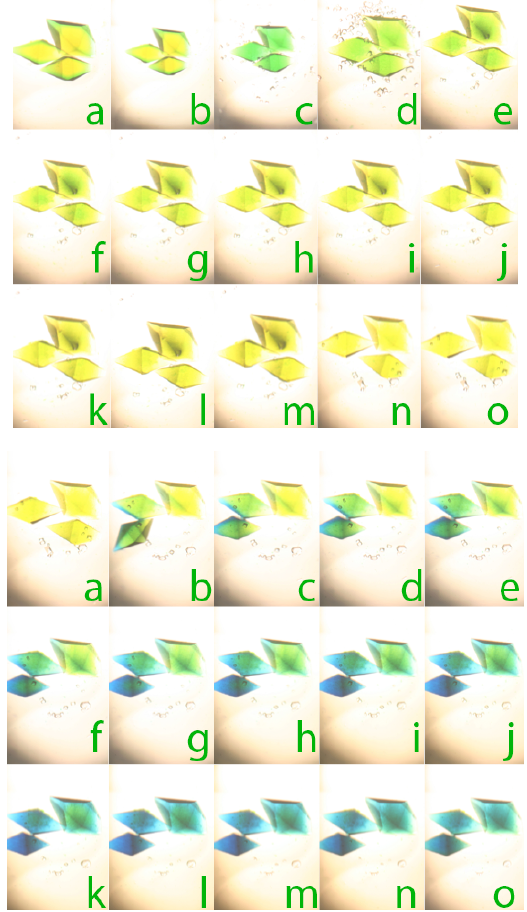
Figure 11. In the top series, tetragonal crystals of thaumatin were first stained to saturation with the dye bromothymol blue, which at pH 6.5 created a yellow color. This was followed by saturation with the dye toluidine blue that gave the crystals a green (yellow + blue) color. Dithionite was then added to the mother liquor and in ( a ) of the bottom series, as the dithionite penetrated the crystal, the toluidine blue was reduced thereby yielding the underlying yellow color due to the pH sensitive bromothymol blue at low pH. Reduction proceeded until ( o ) at which time virtually all of the redox sensitive dye had been reduced. Starting in ( e ) of the bottom panel the pH of the mother liquor was raised to pH 8.2 and the bromothymol blue dye in the crystal transitioned to the blue chemical state. The series of images ( a – o ) in both the upper and lower panels, taken at appropriate time intervals, shows the progress of the dye changes with time, for both pH and redox sensitive dyes.